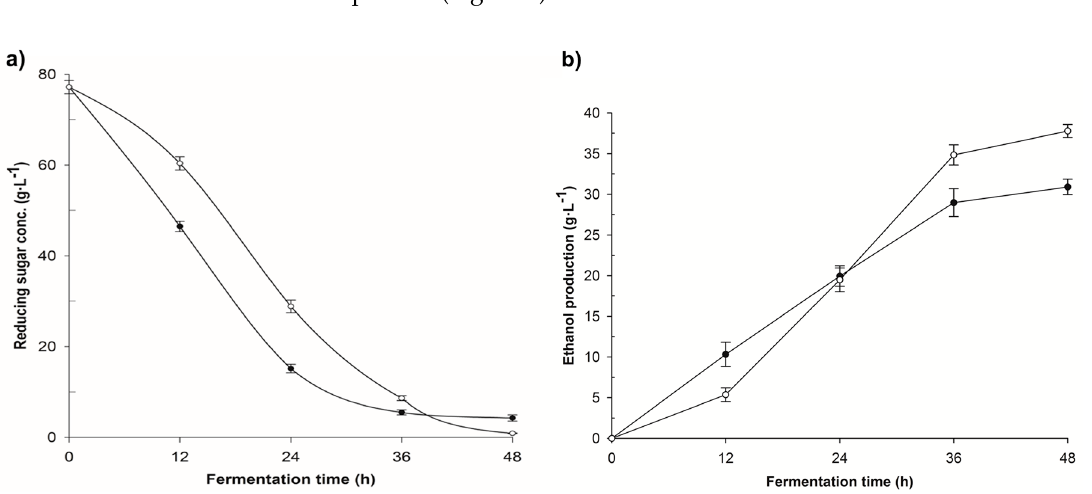
Figure 5. GC chromatogram of the B. alicastrum distillation product fermented with two yeast strains: ( a ) Internal standard; ( b ) S. cerevisiae (Safoeno ® ); and ( c ) C. tropicalis (PL1). As shown in Figure 5b, the commercial S. cerevisiae (Safoeno ® ) strain produced less ethanol than the native yeast strain isolated from B. alicastrum PL1 (Figure 5c). Currently, there is a tendency to use strains isolated from spontaneous fermentations, because it is assumed that they will be better adapted to the system. The calculation of ethanol production for both strains is shown in Figure 6. Strain PL1 ( Candida tropicalis ) exhibited a 31% increase in ethanol production with respect to strain Safoeno ® ( S. cerevisiae ) with values of 213 and 147 mL ∙ kg − 1 flour, respectively.